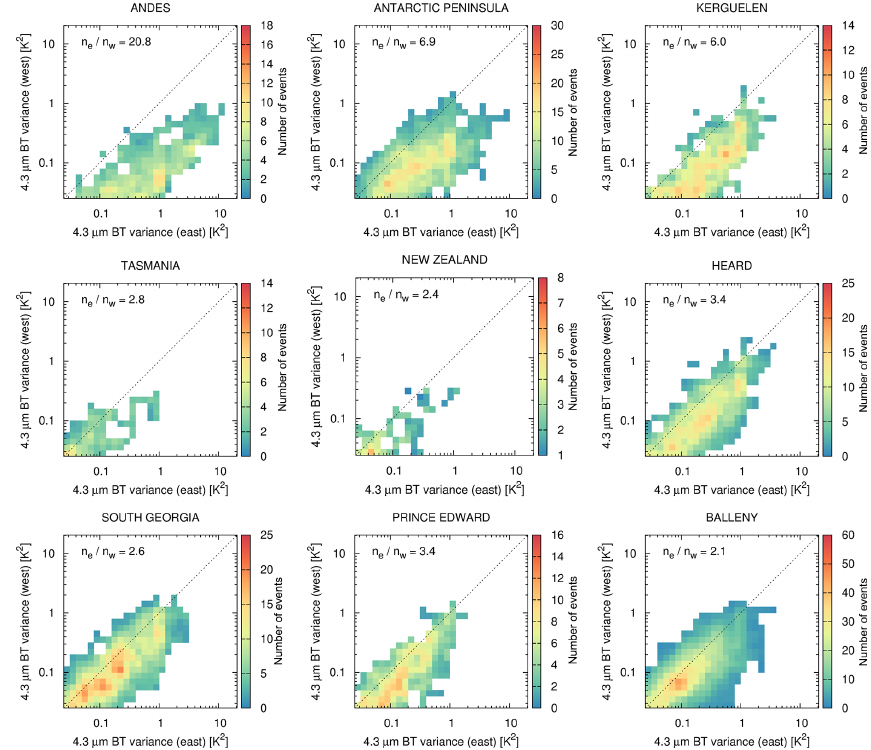
Figure 4. Histograms of 4.3µm brightness temperature variances in eastern and western boxes at selected hotspots. Increased numbers of events in the eastern box indicate orographic wave activity. The ratio n e /n w refers to the numbers of events below and above the identity line, respectively. Note that the total number of events depends on the number of satellite overpasses, which increases for high